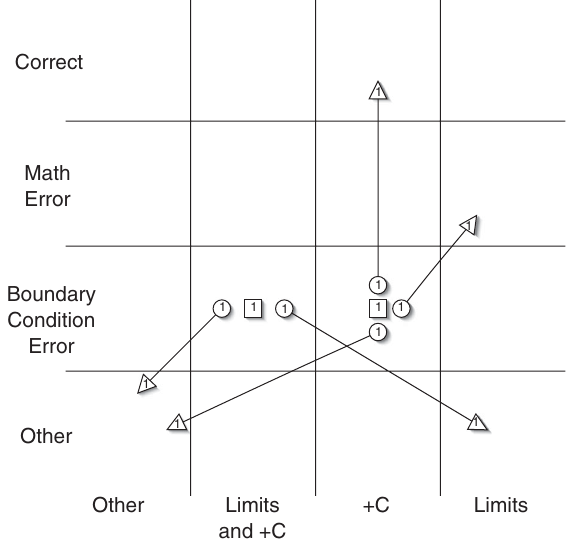
FIG. 11. Starburst pattern representing a subset of data from Fig. 7. Nearly all students leave a given region on the consistency plot. Note that this plot shows examples only, and that not all starbursts in Fig. 7 are